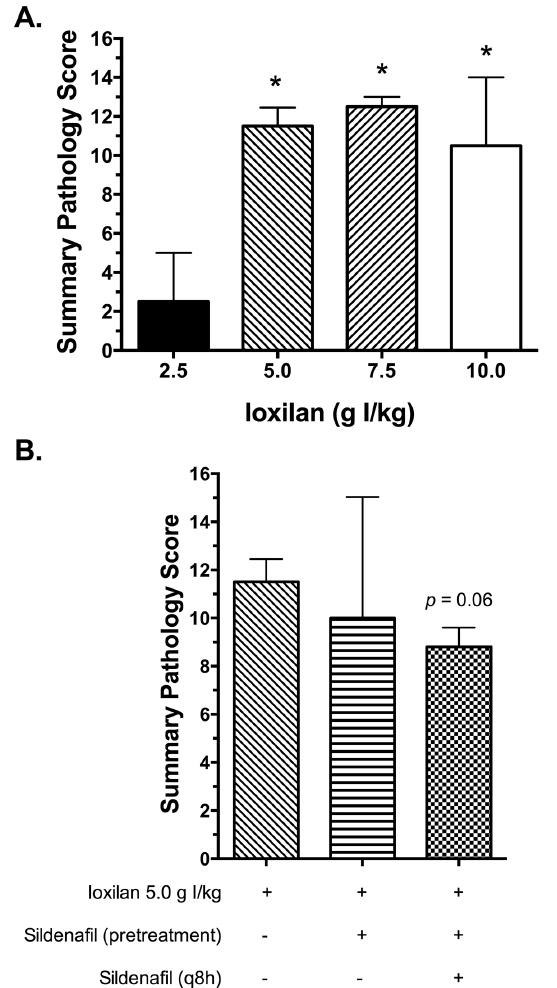
Figure 6. Kidney pathology scores from rabbits subjected to CIAKI. Summary pathology scores were calculated as outlined in the methods. (A) Pathology scores for animals treated with increasing doses of CM. (B) Pathology scores for animals pretreated with sildenafil citrate (6.0 mg/kg; single dose or q8 h) prior to CM exposure (5.0 g I/kg). Values are presented as mean ¡ SEM; n 5 3–5. * indicates p , 0.05 vs. 2.5 g I/kg.